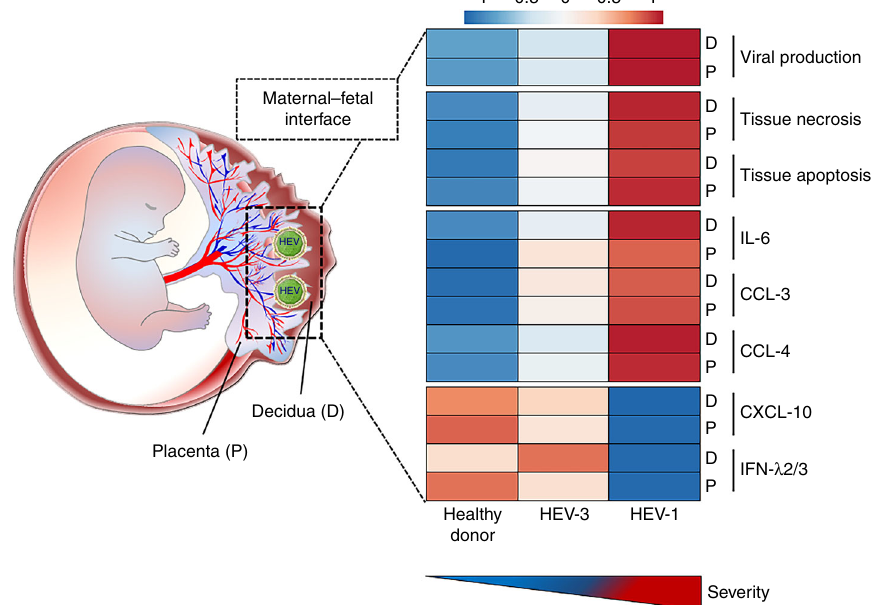
Fig. 9 Genotype-speci fi c pathogenicity of hepatitis E virus at the human maternal-fetal interface. Graphical abstract summarizing the differences observed between HEV-1 and HEV-3 infection in the maternal decidua basalis (D) and fetal placenta (P). Heatmap was generated using mean values for the different parameters analyzed in each study